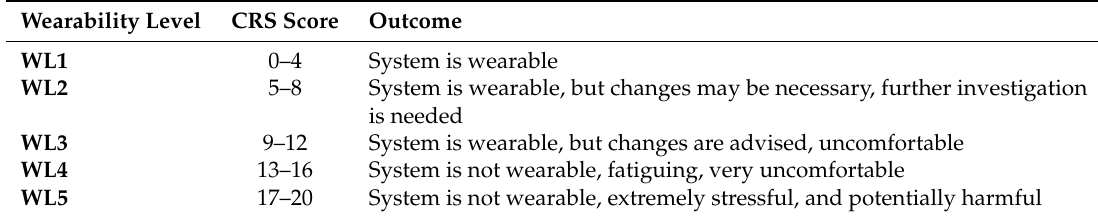
Table 7. Wearability